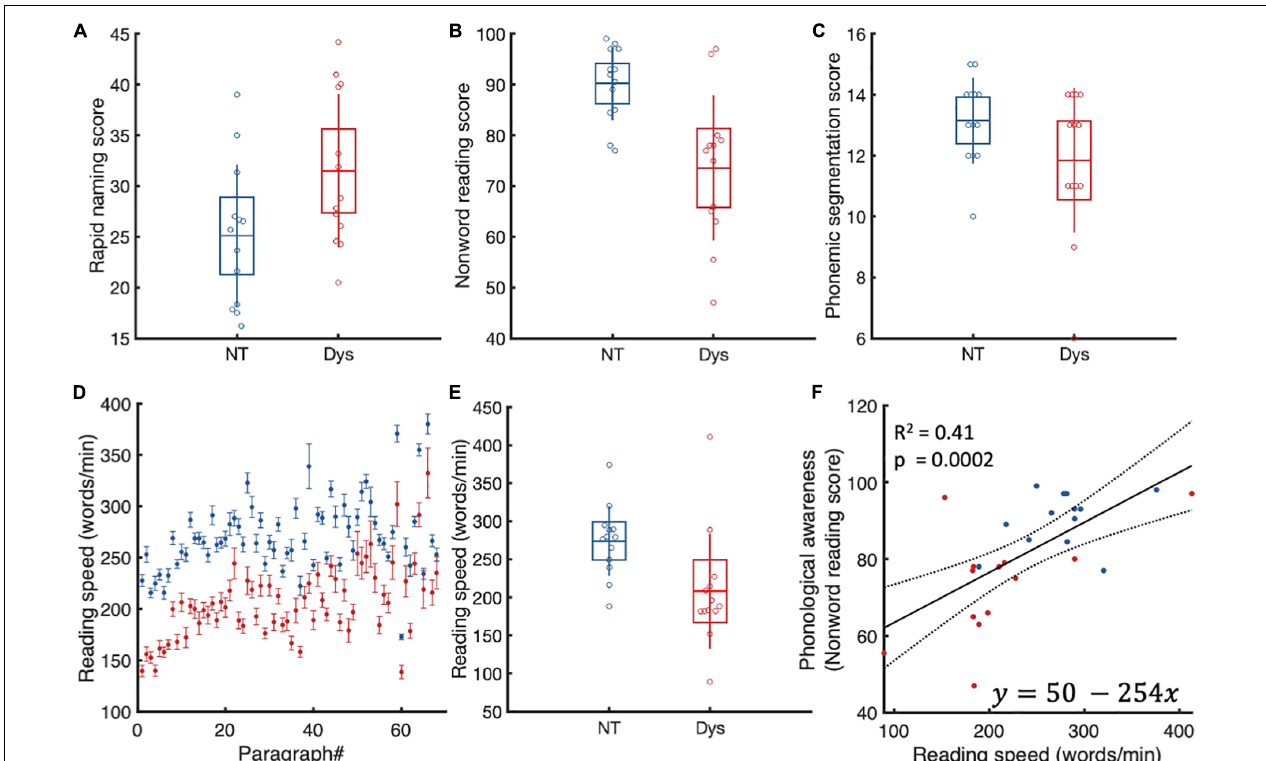
FIGURE 1 | Dyslexia adult screening test scores. (A) Rapid naming. Dyslexics (red) are slower and make more mistakes during rapid naming. (B) Non-word reading. Dyslexics (red) are slower at reading the passage and have more difficulty pronouncing reading non words. (C) Phonemic segmentation. Dyslexics were slower and had more difficulty manipulating phonemes. (D) Reading speed. As expected, dyslexics were slower at reading the same material as neurotypicals. (E) Only non-word reading predicted reading speeds. Dyslexics are in red. Boxes represent standard deviations. (F) Linear regression analysis of reading speed and phonological awareness. As expected faster readers had better phonological